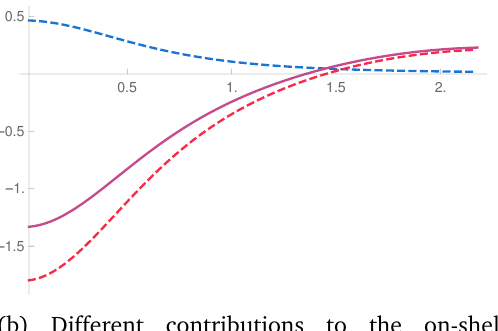
(a) Energy densities in the backreacted cusp so- lution in units of (cid:96) . The warping-corrected cur- 11 (cid:16) (cid:1) 2 (cid:17) − ˆ R − 3 (cid:0) ∇ u is displayed in green; vature u 2 7 u | 2 in orange and the u 2 | F the flux contribution 1 7 2 in blue. Casimir energy density − u 2 ˆ R − 11 c